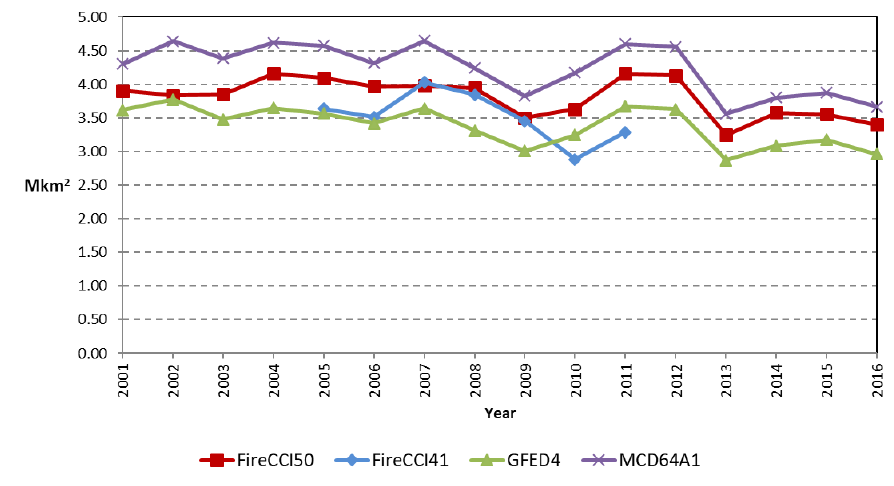
Figure 6. Temporal trends of yearly BA for different global products. Table 3. Correlation matrix showing the coefficients of determination ( r 2 ) calculated for different BA product pairs based on annual data (see Fig. 5). The average and the range calculated from individual years in 2005–2011 are given.